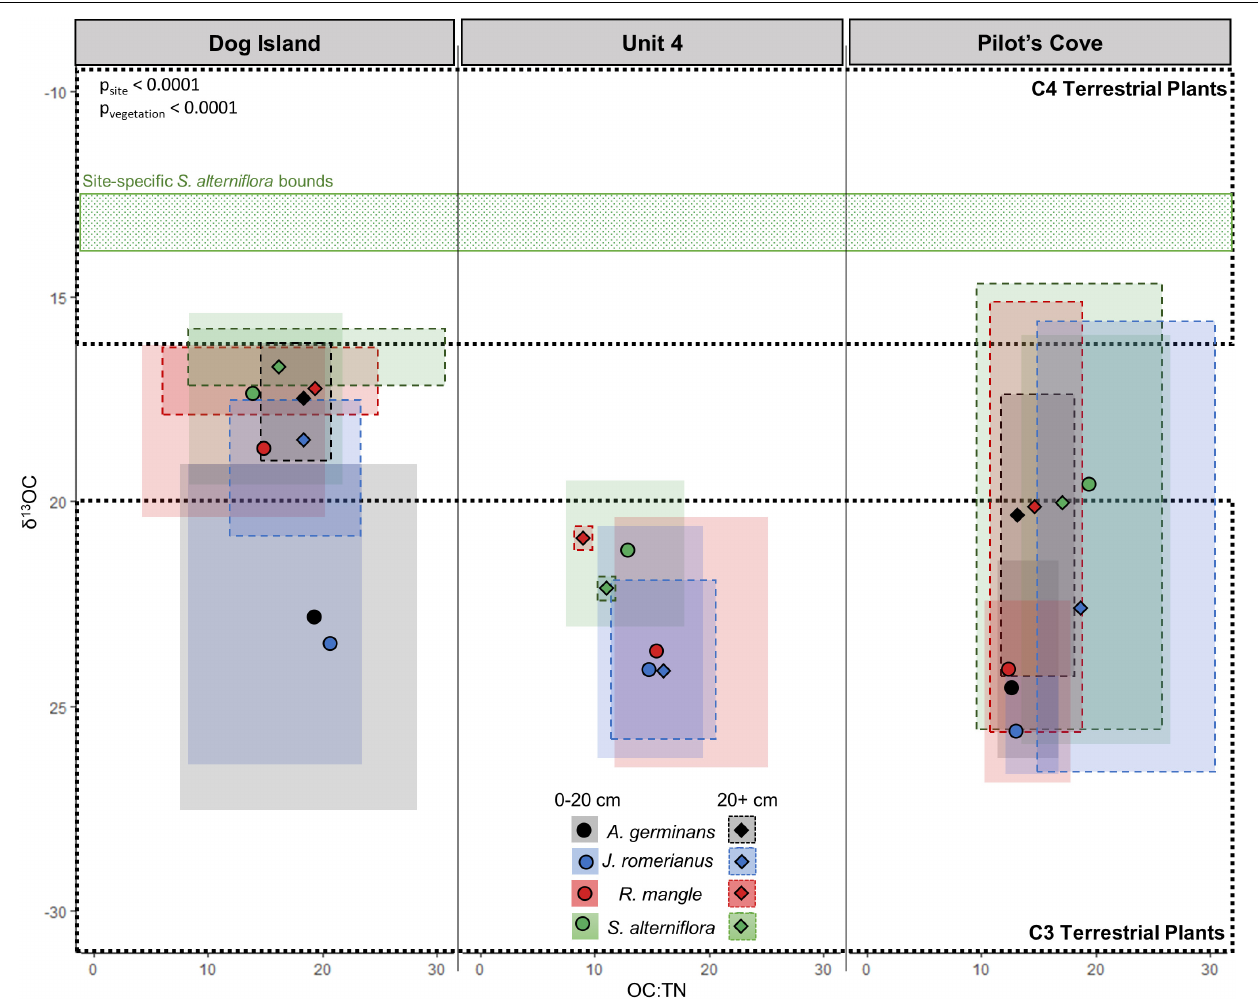
FIGURE 4 | Ratio of organic carbon to total nitrogen, plotted with δ 13OC by site (entire soil profile). Points represent mean and the size of the box represents the spread of the data. Dashed boxes and diamonds denote depths greater than 20 cm while unbounded boxes and circles denote depths less than 20 cm. Bounds of C3 and C4 terrestrial plants from Lamb et al. (2006) are indicated by bold dashed boxes. Site-specific S. alterniflora bounds are from Chanton and Lewis